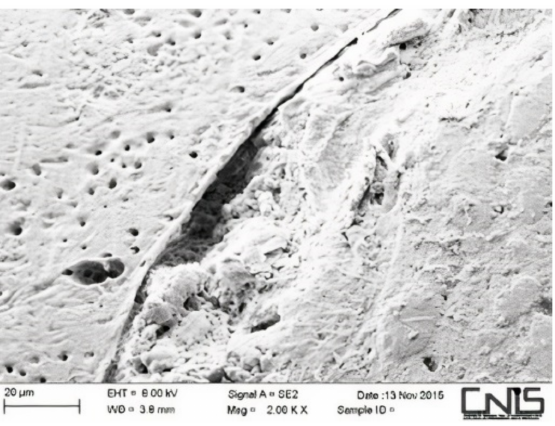
Figure 3. Interface between dentin and sealant. Section of third apical third T system.